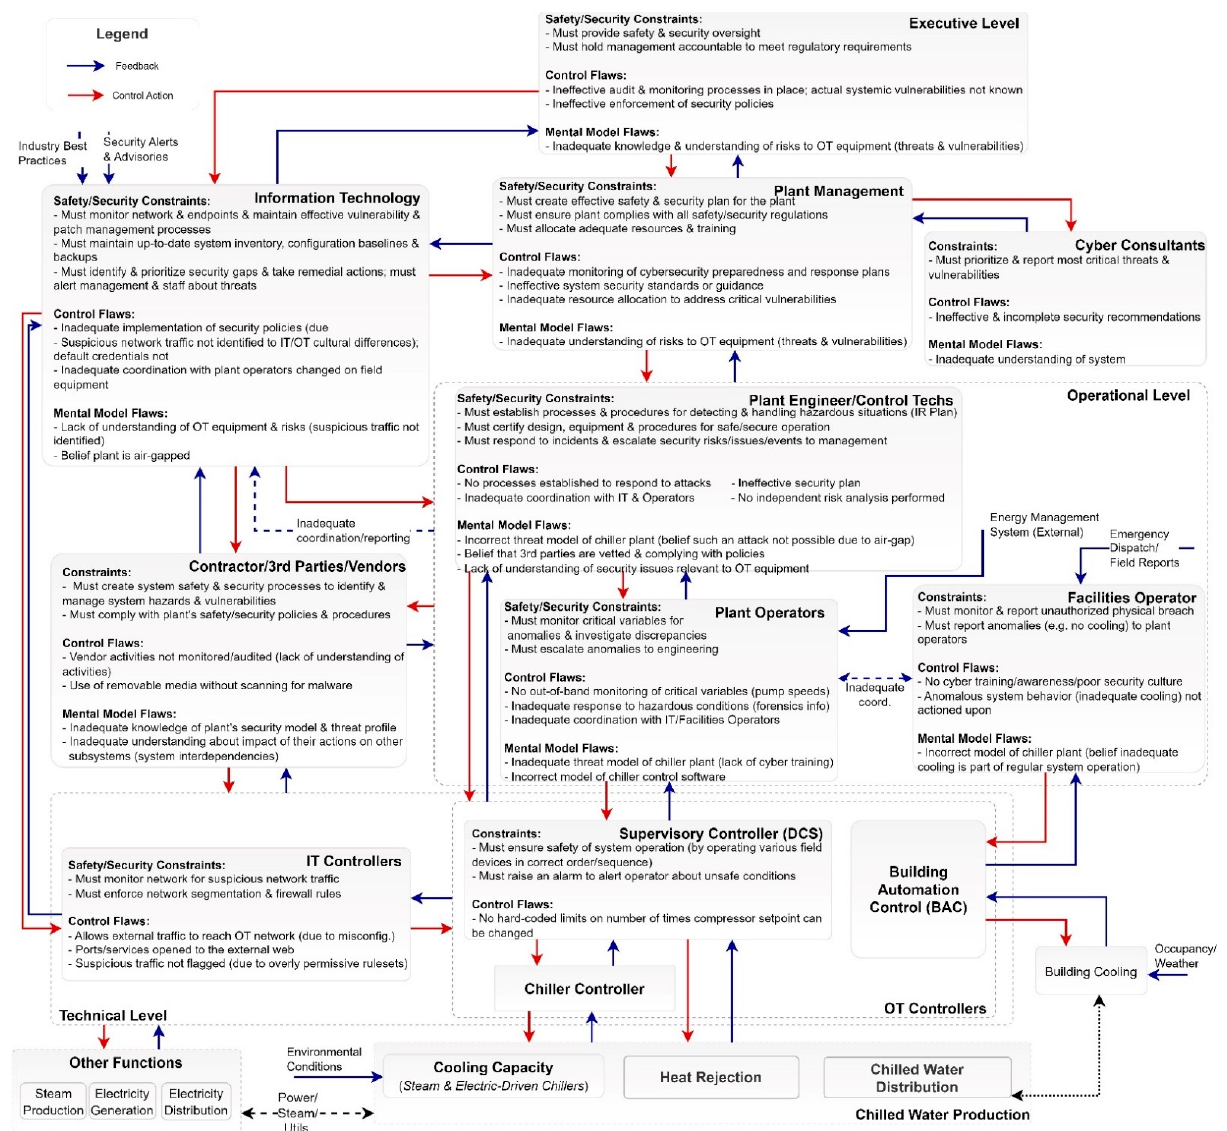
Figure 5. Summary of flaws in the larger socio-organizational structure.